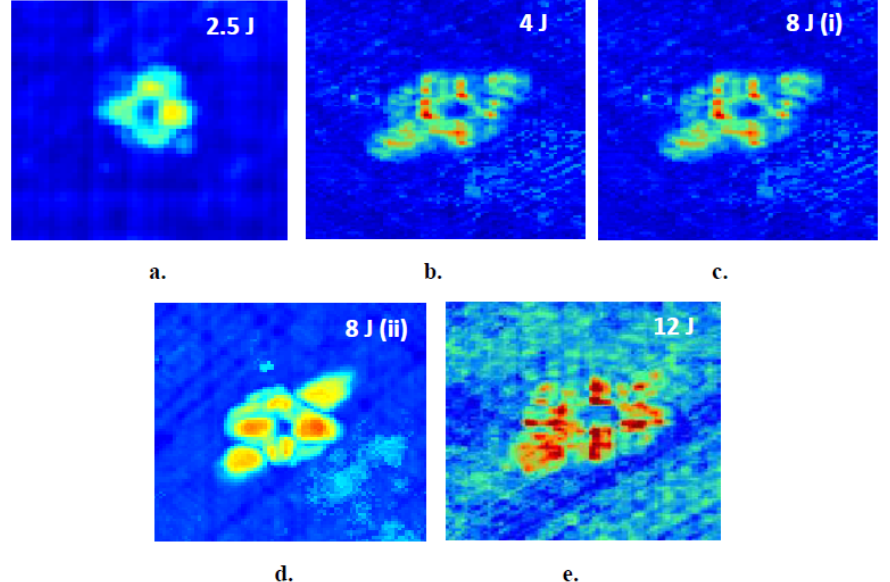
Figure 8. Ultrasonic C-Scan images in thin, 9-layer composite laminates for different levels of impact energies. ( a ) 2.5 J, ( b ) 4 J, ( c ) 8 J, ( d ) 8 J, ( e ) 12 J.